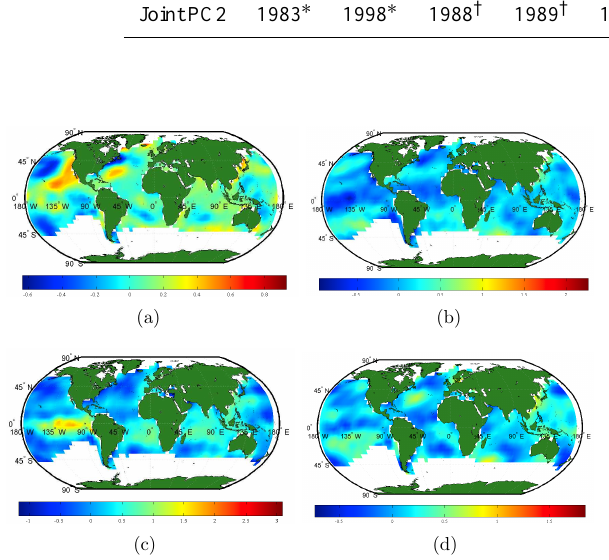
Fig. 7. Average SSTa in the previous winter months (DJF) dur- ing five years with lowest or highest PCs values from Joint PCs. (a) Years with lowest PCs values from Joint PC1; (b) years with highest PCs values from Joint PC1; (c) years with lowest PCs val- ues from Joint PC2; (d) years with highest PCs values from Joint PC2.